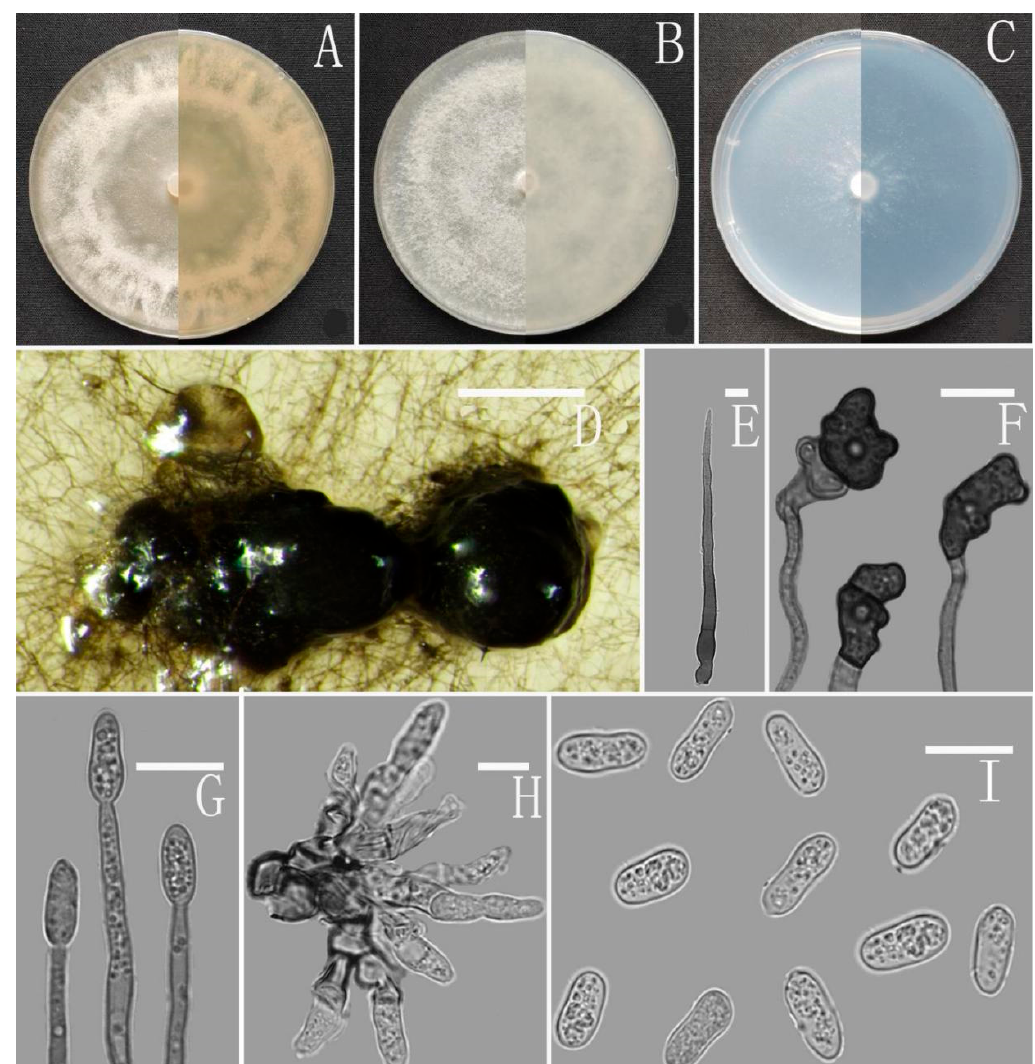
Figure 4. Colletotrichum cangyuanense (YMF 1.05001). ( A – C ) Colonies on media above and below after 7 days at 25 °C (( A ) MEA; ( B ) PDA; ( C ) SNA). ( D ) Conidiomata. ( E ) Setae. ( F ) Appressoria. ( G ) Conidiophores. ( H ) Conidiophores and Conidia. ( I ) Conidia. Scale bars: ( D ) = 100 µ m, ( E – I ) = 10 µ m. Sexual morph not observed. Asexual morph on CMA. Conidiomata rudimentary, forming smaller aggregates of the mycelium with conidia droplets, dark olivaceous brown. Setae and conidiophores formed directly on hyphae. Setae scarce, cylindrical, straight or slightly flexuous, dark brown to black, 4–6-septate, base cylindrical to slightly inflated, tip acute to rounded, up to 102 µ m. Conidiophores pale brown, aseptate, sometimes branched. Conidiogenous cells hyaline, smooth-walled, septate, subulate or cylindrical. Conidia hyaline, smooth-walled, cylindrical, slightly constricted at the middle, apex rounded, base obtuse, subtruncate, 15.5–20 × 4.5–5.5 µ m, mean ± SD = 17.6 ± 1.3 × 5.1 ± 0.3 µ m, l/w ratio = 3.5. Appressoria produced from mycelia, irregular, brown, branched, 12–16 × 6–11.5 µ m. Culture characteristics: Colonies on MEA flat forming a concentric ring with entire margin, occupied the whole plate in 7 days at 25 °C, surface grayish white, aerial mycelia medium hyaline to gray in the center, light gray to grayish white in the margin, partly covered with short felty whitish aerial mycelium, reverse same colors. Colonies on PDA flat forming a concentric ring with entire margin, occupied the whole plate in 7 days at 25 °C, aerial mycelia cotton-shaped, white to pale gray with circular margin, reverse same colors. Colonies on SNA flat with entire margin, occupied the whole plate in 7 days at 25